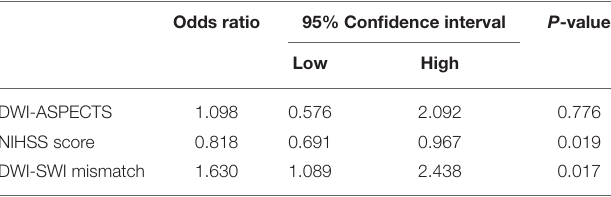
TABLE 2 | Prognostic indices in patients with MCA M1-segment occlusion. Odds